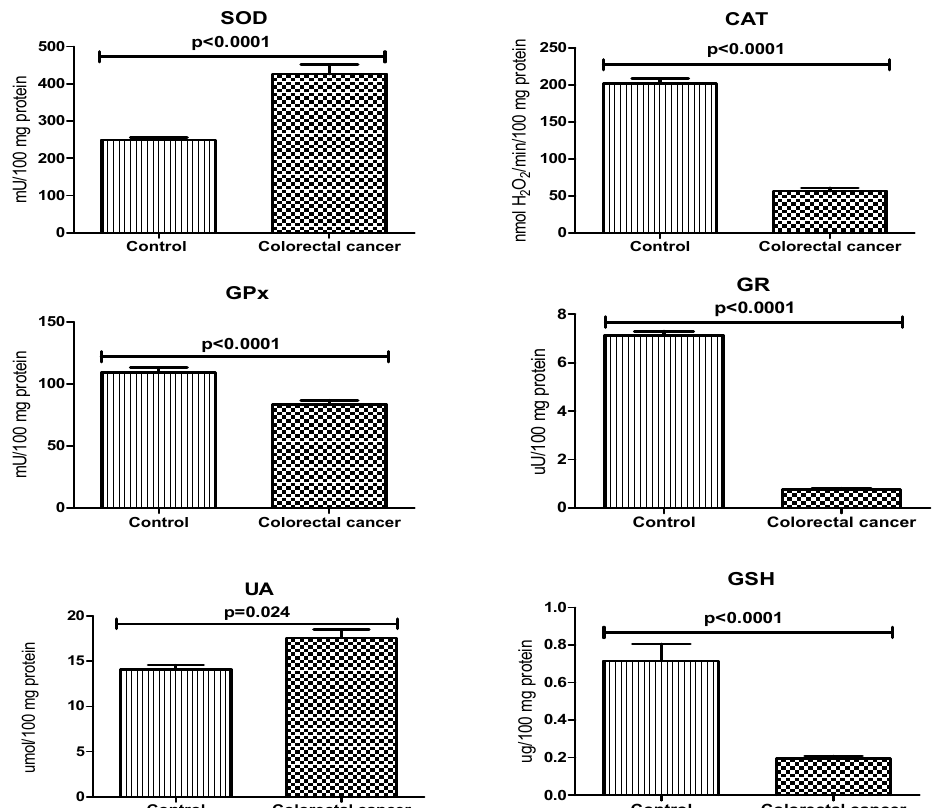
Figure 2. Non-enzymatic and enzymatic antioxidant defence in patients with colorectal cancer and the control group. Abbreviations: SOD, superoxide dismutase-1; CAT, catalase; GPx, glutathione peroxidase; GR, glutathione reductase; UA, uric acid; GSH, reduced glutathione.